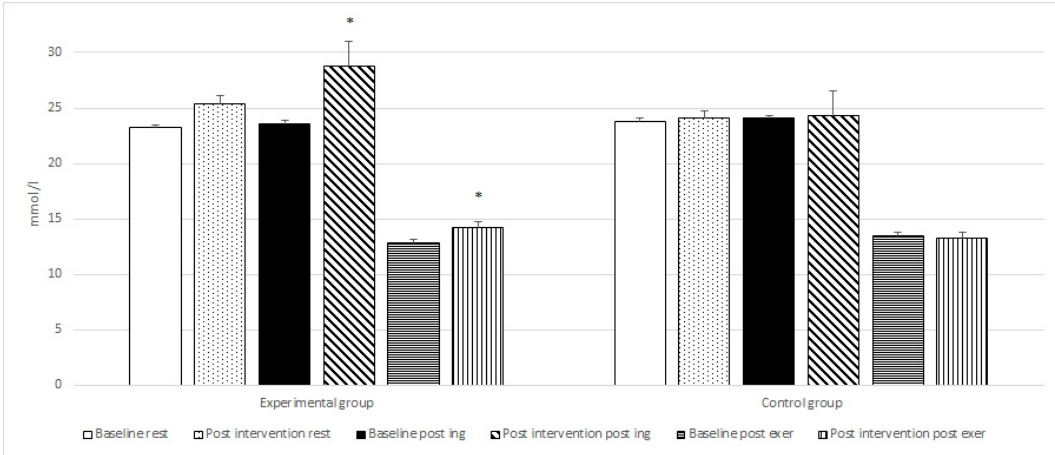
Figure 3. Baseline and post intervention blood HCO 3 − at rest, post ingestion, and post exercise in the experimental and control groups. * statistically significant.